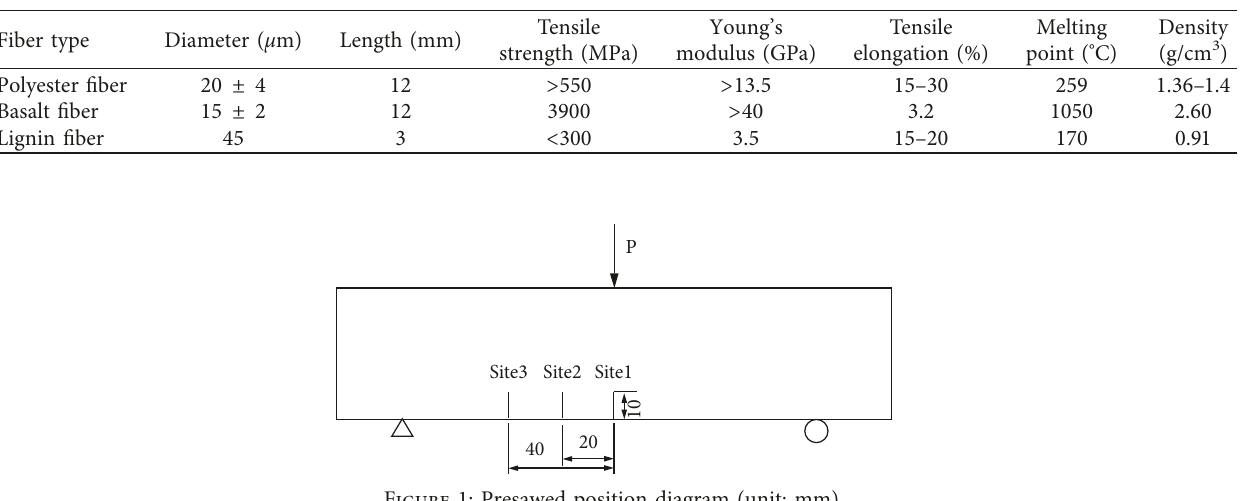
Table 3: Technical indicators of fibers.